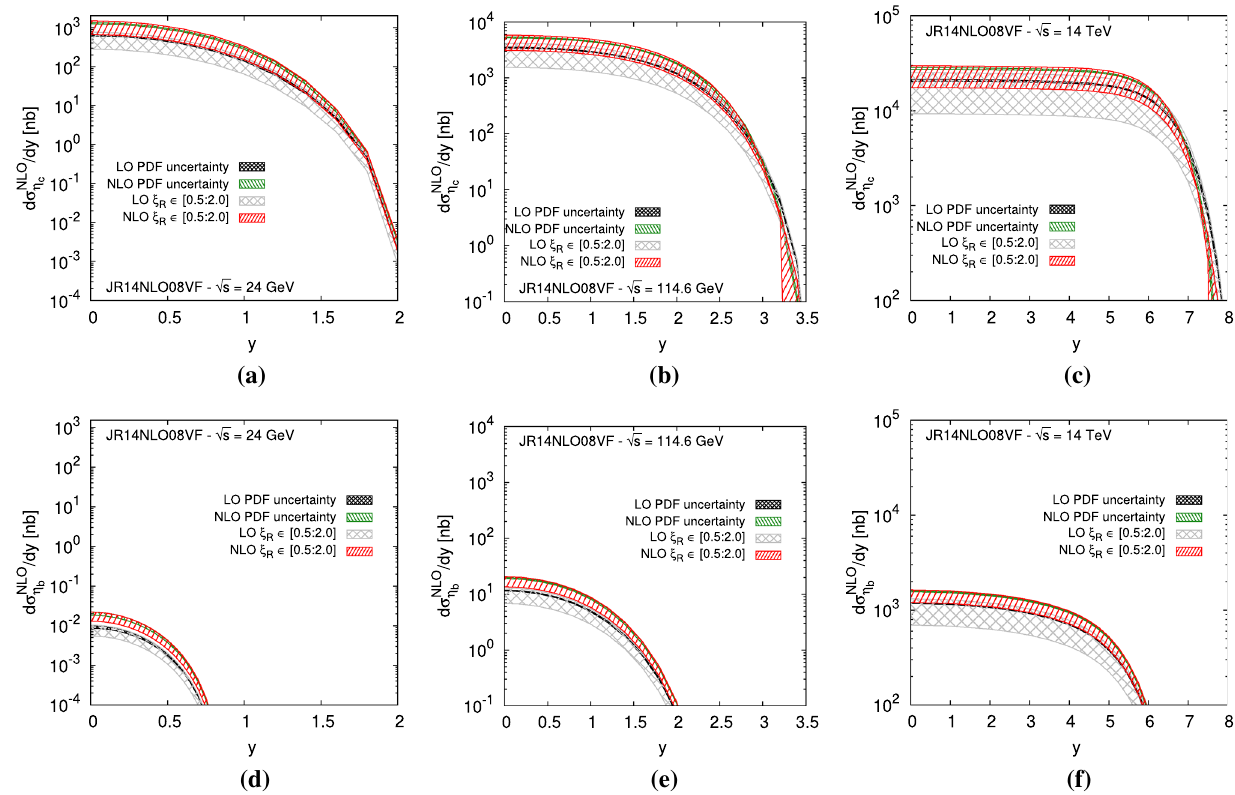
Fig. 11 d σ NLO for η c (top) and η b (bottom) as a function of y at √ dy s = 24 GeV(left), 114.6 GeV (middle), 14 TeV (right), for μ F = ˆ μ = μ F R for JR14NLO08VF at LO and NLO. The green (black)